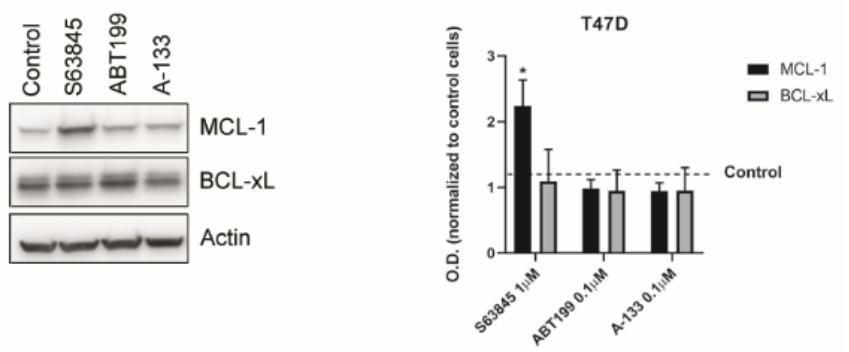
Figure 3. The identified resistant mechanisms are not due to overexpression of anti-apoptotic proteins. Left panel: Representative images from Western blot analysis of T47D control lysates and after treatment with BH3 mimetics for 16 h. Right panel: Optical density quantification normalized to actin and represented as fold change compared to control. S63845 treatment significantly increases MCL-1 expression due to its stabilization. Values indicate mean values ± SEM. * p < 0.05 and all experiments were performed at least three times.